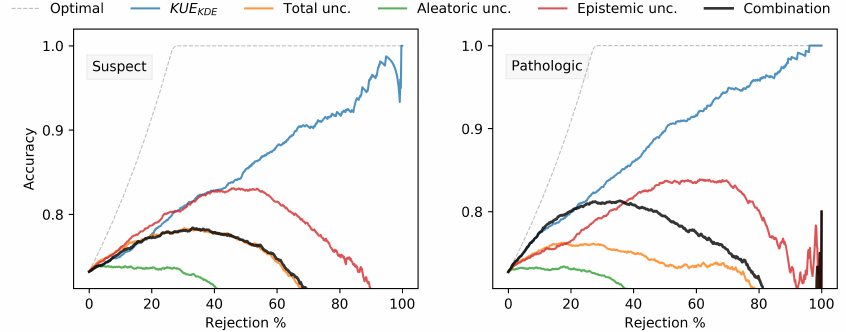
Figure A3. AR curves for aleatoric, epistemic and total uncertainty for the Cardio dataset. The curve for perfect rejection is included as a baseline. The name in each plot represents the OOD input